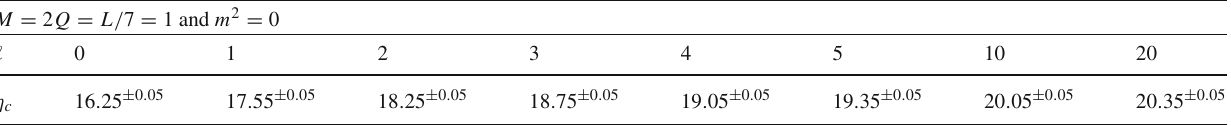
Table 6 Critical values of η (the field evolves stably after η > η c ) M = 2 Q = L / 7 = 1 and m 2 = 0